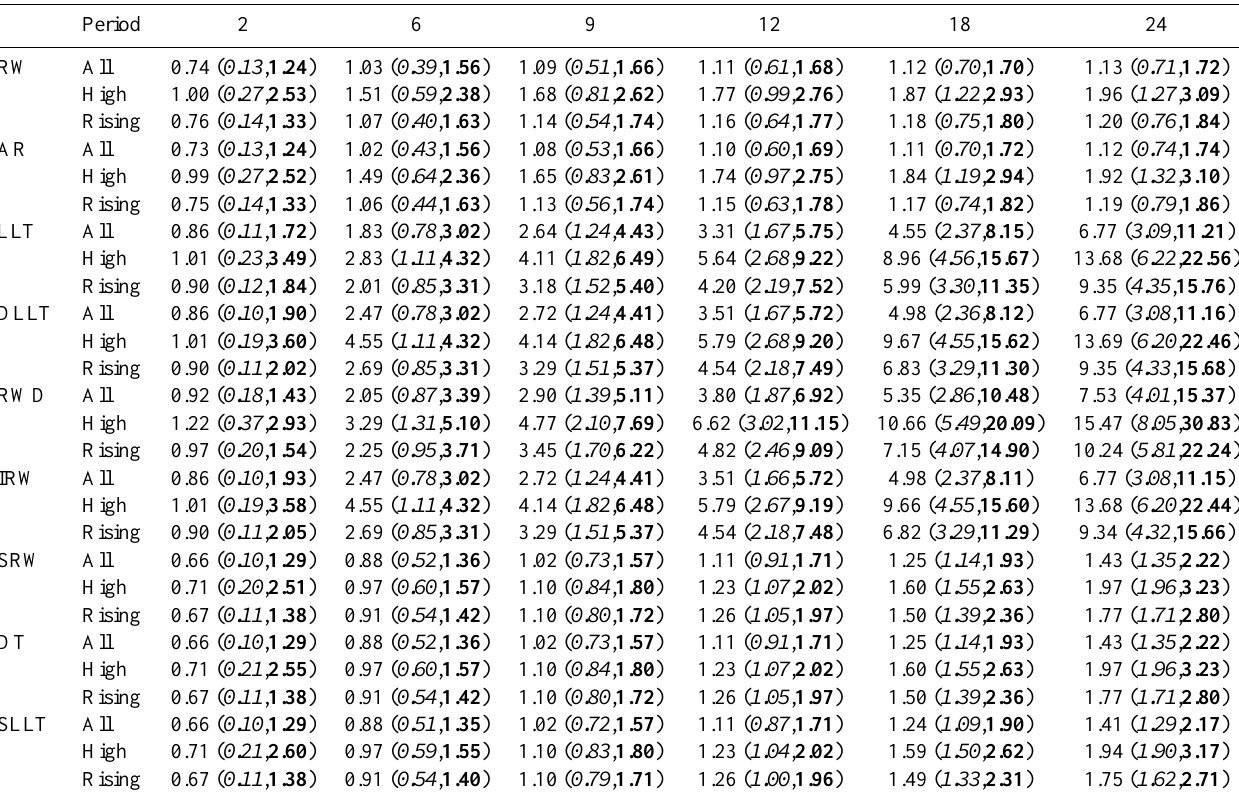
Table 8. Precision of the forecasts (see text for definition) during calibration at Llandrinio. Bracketed results are those for the SEFE calibration with the italicised and bold values corresponding to the empirical and theoretical symmetric bounds. Results are shown for all the time period, high levels ( > 4m) and periods where the hydrograph is rising for different combinations of lead time (hours) and GRW